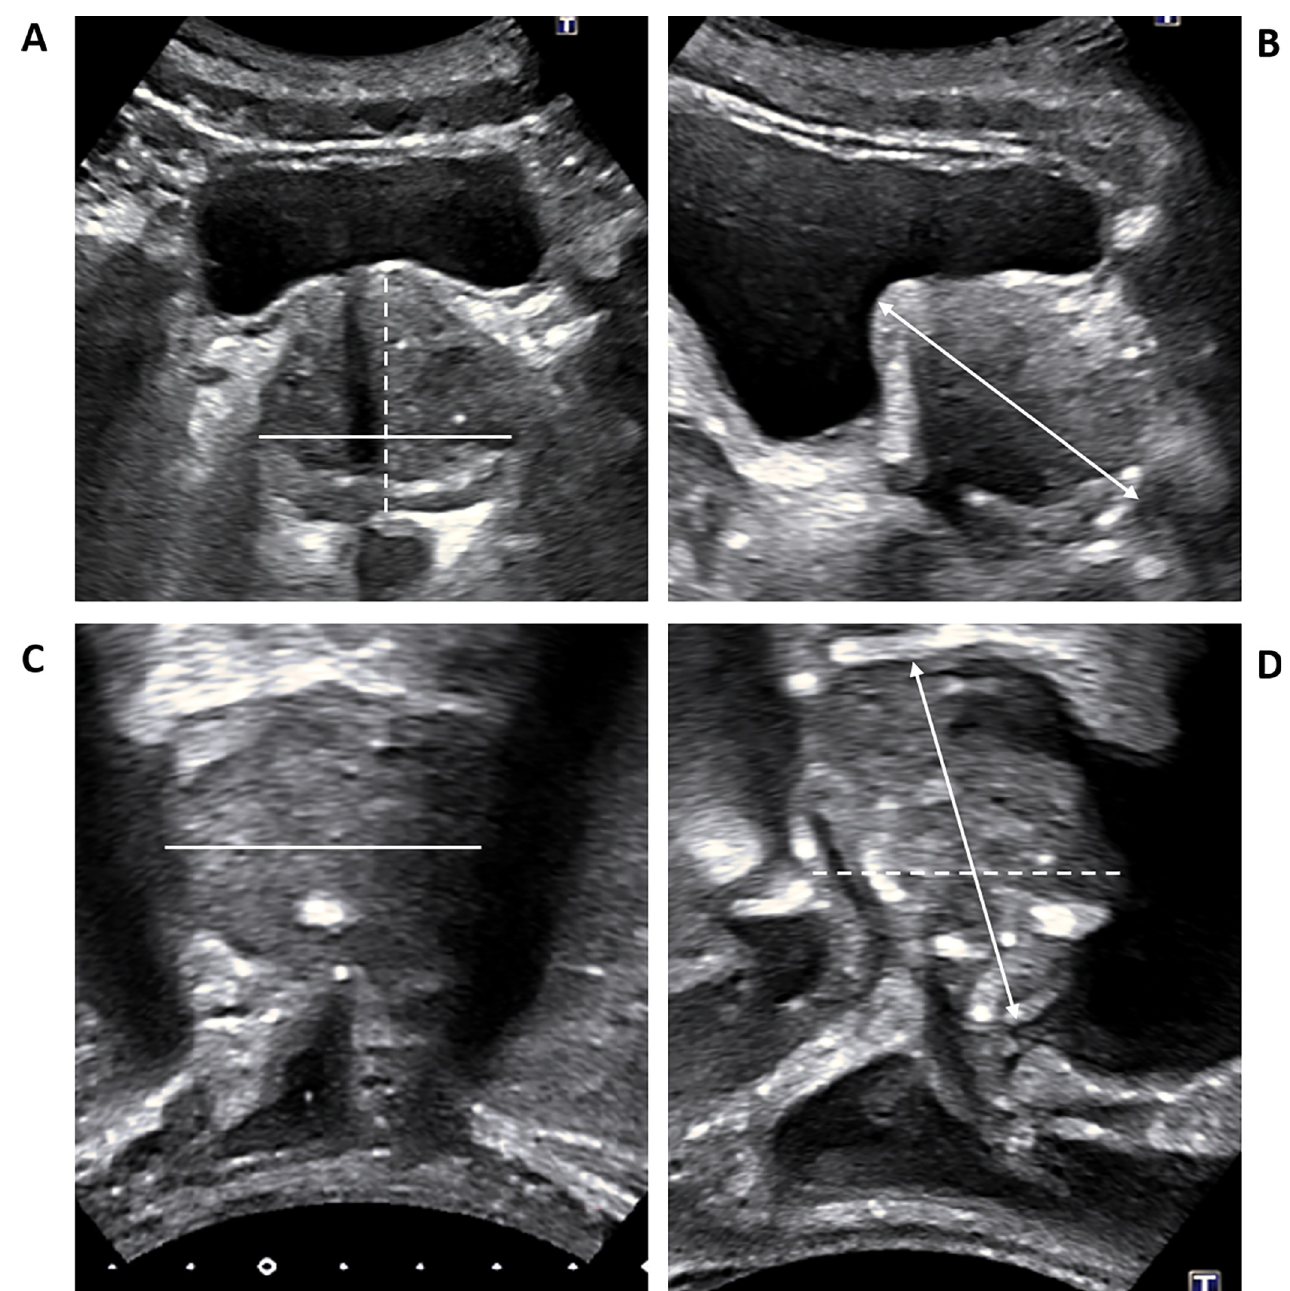
Fig 1. Ultrasound views obtained. Transabdominal views in the transverse/axial (A) and longitudinal/sagittal (B) planes. Transperineal views in the longitudinal/sagittal (C) and transverse/coronal planes (D). Lines represent “Axial 1” measurements (right to left), dashed lines represent “Axial 2” measurements (anterior-posterior), arrowed lines represent Sagittal